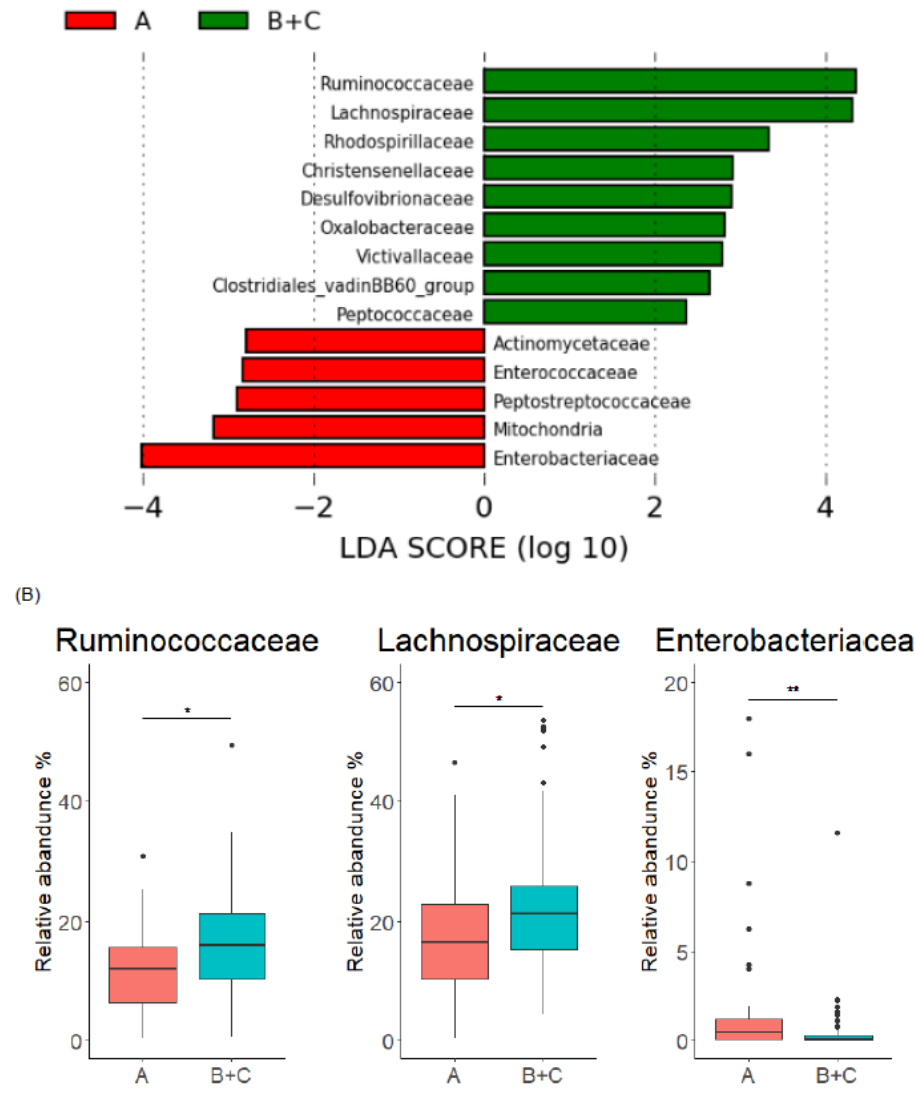
Figure 3. Comparison of gut microbiome composition at family level between enterolignan producers and non-producers. ( A ) LEfSe analysis at family level of enterolignan producers (Group B + C) and non-producers (Group A). ( B ) Comparison of relative abundance of Ruminococcaceae, Lachnospiraceae, and Enterobacteriaceae between enterolignan producers (Group B + C) and non-producers (Group A). In the box plots, the boundary of the box closest and farthest to zero indicates the 25th and 75th percentile, respectively, and a black line within the box marks the median. Whiskers indicate minimum and maximum values. Points above the whiskers indicate outliers. Statistical significance was evaluated by Mann − Whitney U test. * p < 0.05, and ** p < 0.01.